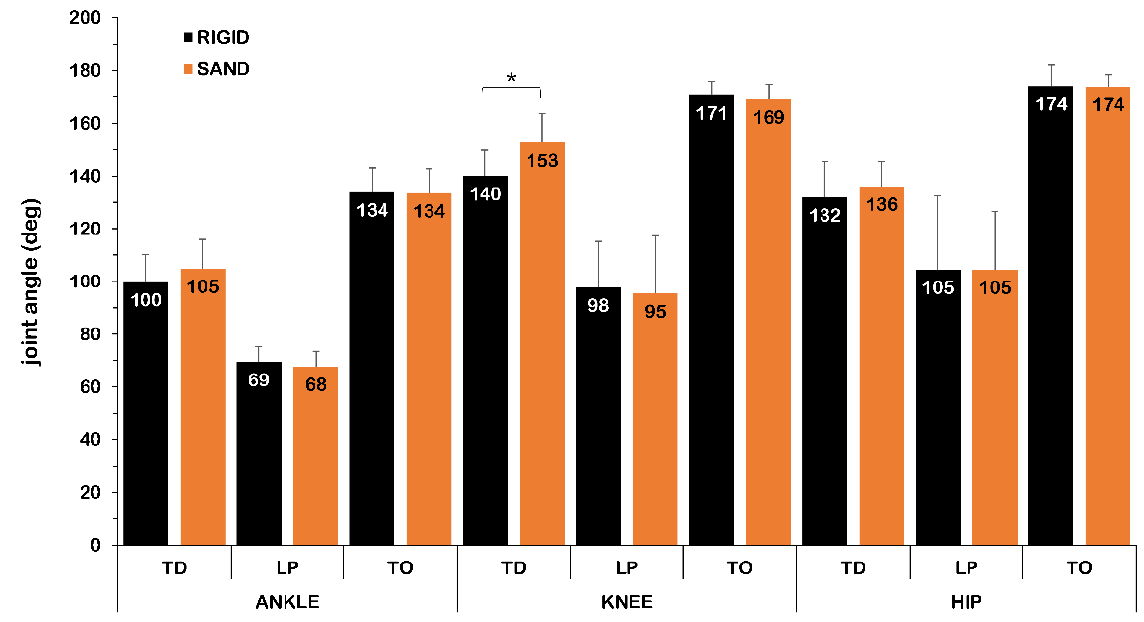
Figure 3. Joint angles at the instants of touchdown (TD), lowest vertical position of the body center